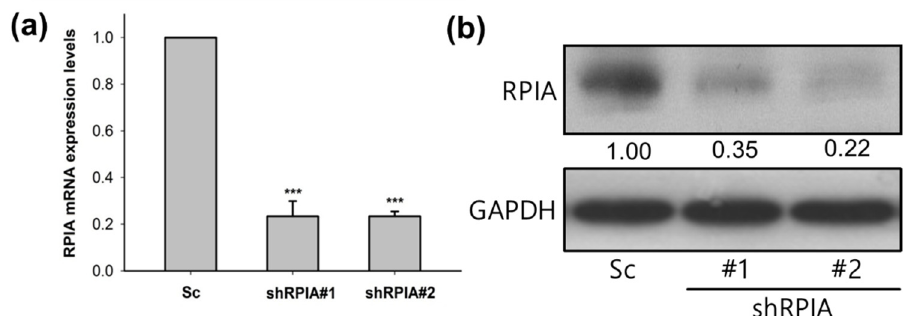
Figure 2. The mRNA and protein expression levels of RPIA were reduced in the two RPIA shRNA knockdown A549 lung cancer cells. ( a ) The RPIA mRNA levels were measured by Q-PCR in A549 lung cancer cells infected with either Scramble (Sc) control or shRNA (shRPIA#1 and shRPIA#2). Statistical analyses were done by Student t -test, *** p < 0.001. ( b ) The RPIA protein levels were examined by Western blot in A549 lung cancer cells infected with either Scramble (Sc) as control or shRNA (shRPIA#1 and shRPIA#2). GAPDH was used as an internal control.